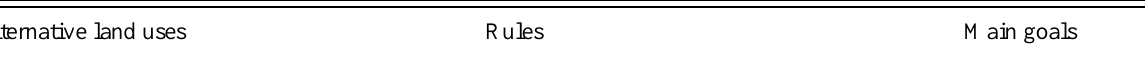
Table 2 . Aggregated list of alternative land uses (including linear landscape elements), rules for their incorporation in the MS, and main